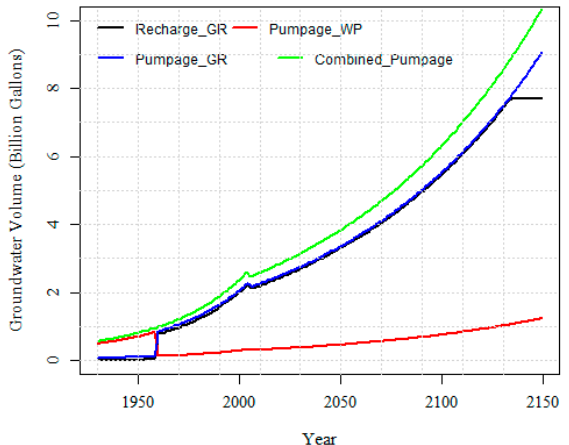
Figure 8. Simulation result of recharge to Grand Ronde (GR), GR pumpage, WP pumpage and total Pumpage (1% population growth).